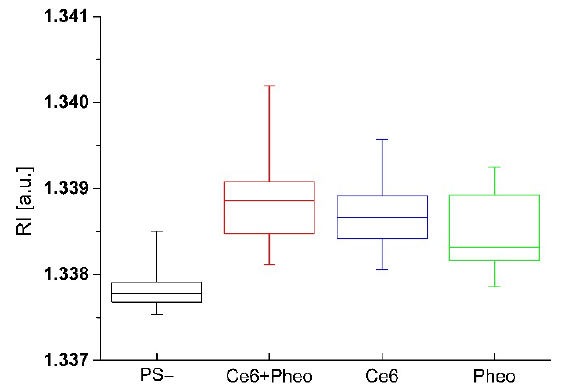
Figure 3. The change of RI values of cells with and without PS after 24 h incubation.